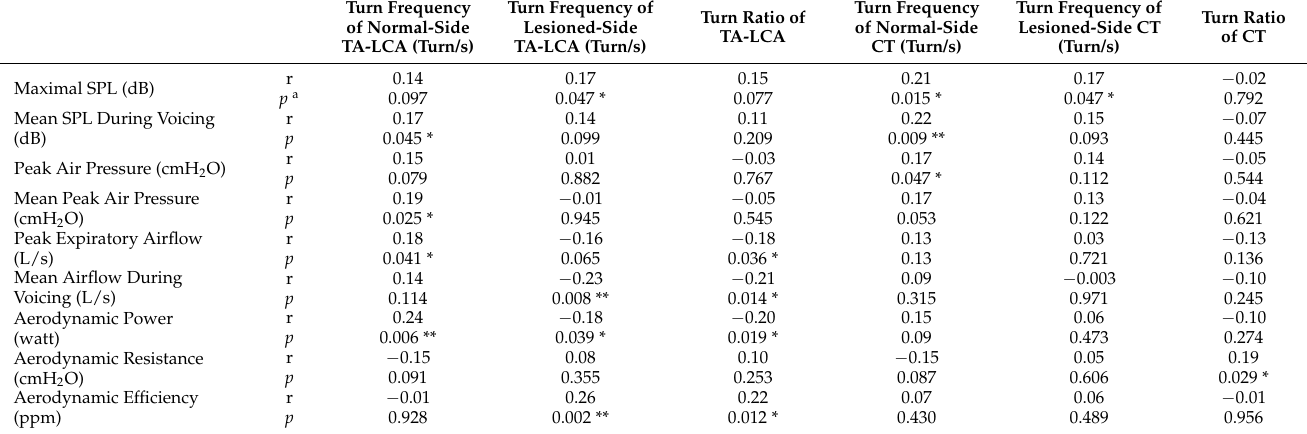
Table 4. Correlation between LEMG and